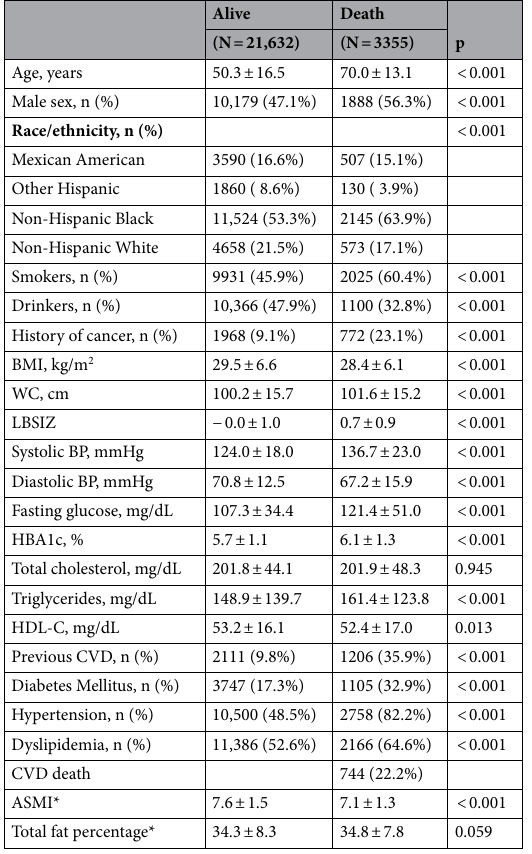
Table 1. Characteristics of subjects according to all-cause mortality. BMI body mass index, WC waist circumference, LBSIZ z-score of the log-transformed A Body Shape Index, HBA1c hemoglobin A1c, HDL-C